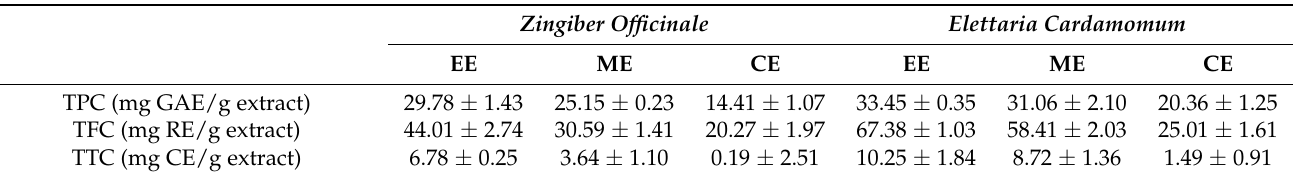
Table 2. Total content of phenols, flavonoids and tannins of Zingiber officinale Roscoe and Elettaria cardamomum (L.) Maton extracts. Zingiber